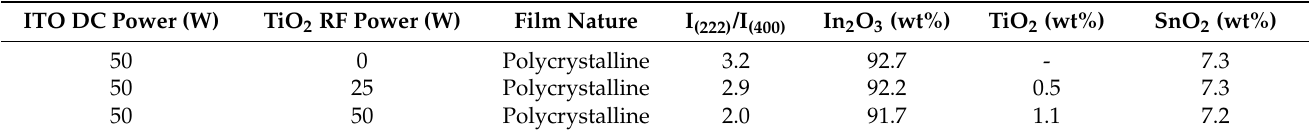
Table 7. Compound’s concentrations, estimated by WD-XRF, as function of the used power values. The nature of the film and the (222)/(400) diffraction peak intensity ratio are included. ITO DC Power